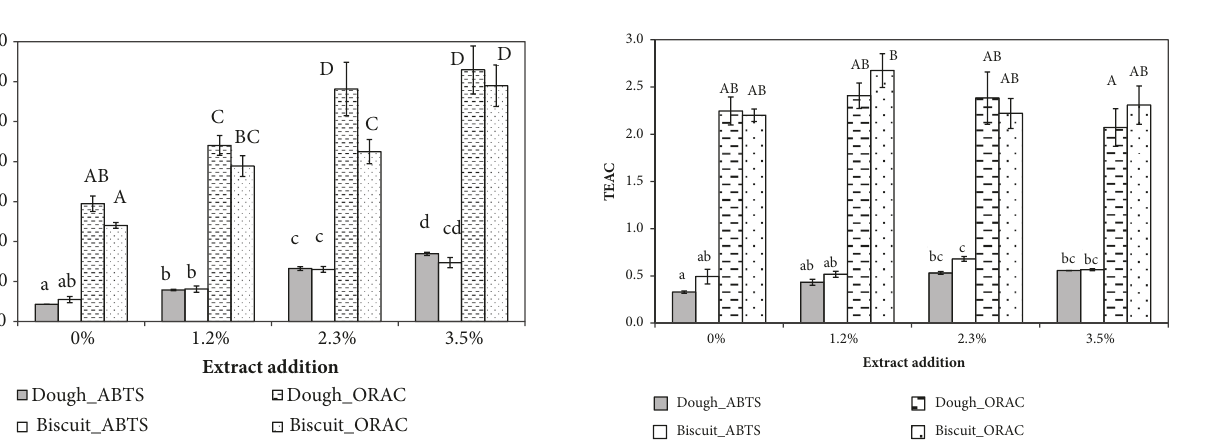
Figure 3: Influence of grape skin extract addition at different levels (0, 1.2, 2.3, and 3.5% on dough weight) on the specific antioxidant capacity (TEAC = mol Trolox (cid:2) / mol GAE ) of dough and biscuit, based on the ABTS assay or the ORAC assay. Different lowercase letters indicate means statistically different for the ABTS results, while uppercase letters indicate means statistically different for the ORAC results, according to ANOVA analysis and post hoc Tukey’s test (p < 0.01). Error bars indicate ± SD of mean values (n =